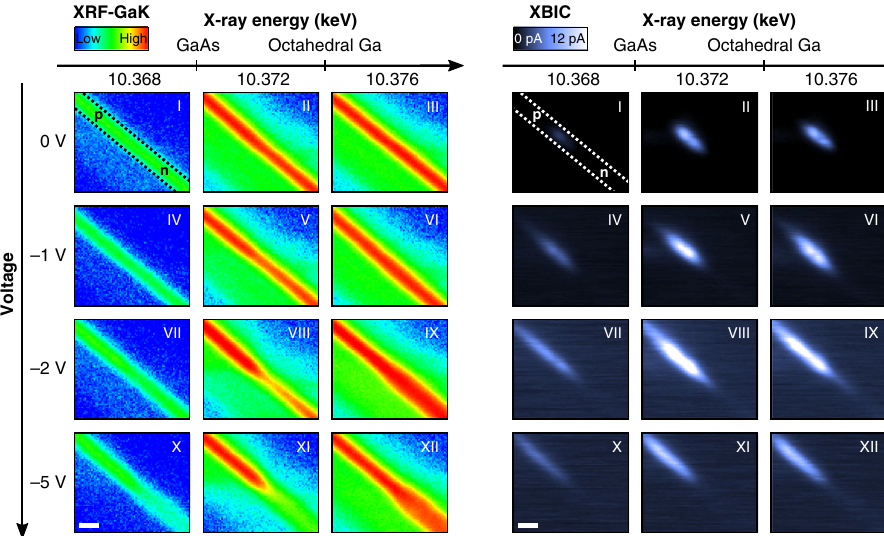
Fig. 3 Energy and voltage dependence of nano XRF and nano XBIC. Ga K α X-ray fl uorescence (XRF; left) and X-ray beam induced current (XBIC; right) maps of the p – n junction taken as a function of applied voltage and excitation X-ray energy. The GaAs nanowire (as located in the Ga map) is indicated by the dashed, black and white lines, respectively. The Roman numbers indicate the measurement sequence and XRF counts and XBIC currents are scaled equally on a logarithmic scale for all voltages and energies, respectively. The spatial scale bar is 300